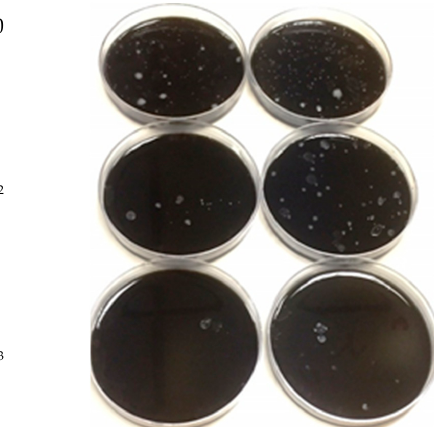
Figure 2. Total viable counts (TVCs) of Campylobacter jejuni ATCC 33291 isolated from camel meat after treatment and cultured on Campylobacter blood-free selective medium (modified CCDA-